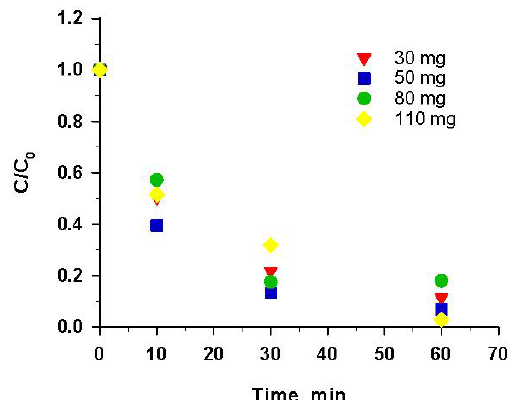
Fig. 11. Different phenomena impact removing MB in optimum =2 ppm, operating 0